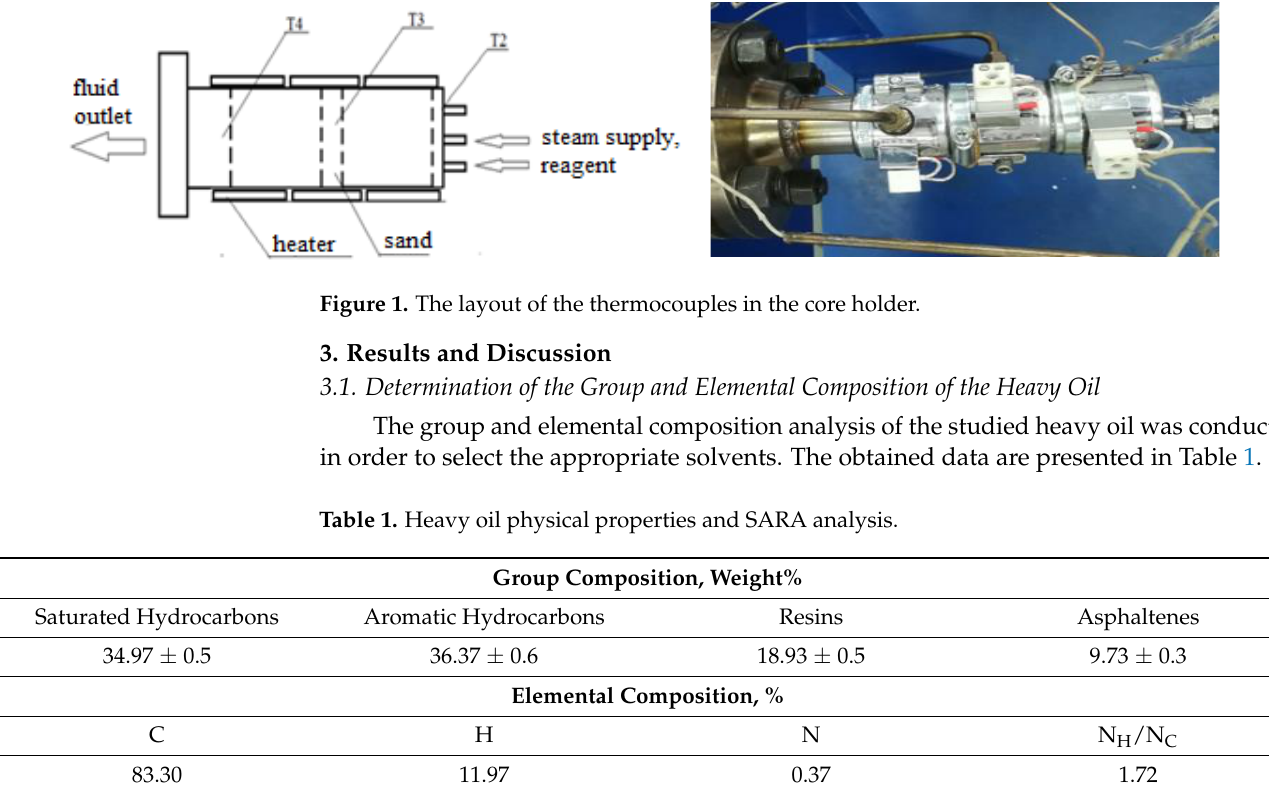
Table 2. Physical properties and chemical composition of the used solvents.